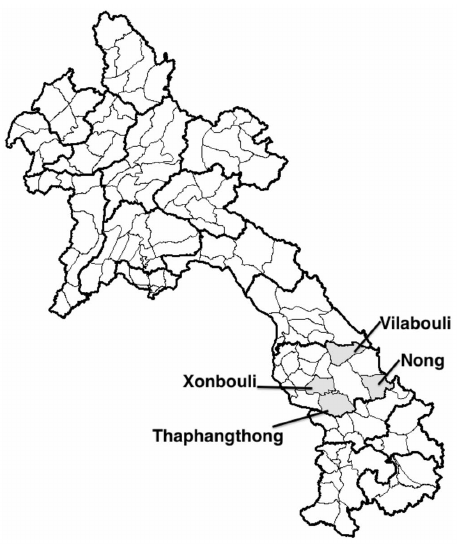
Figure 3. Map of Laos.